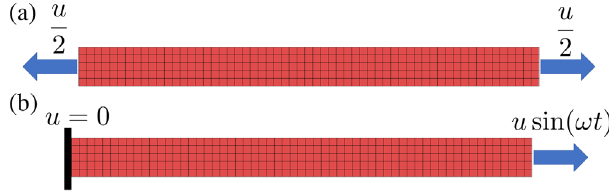
FIG. 14. A long bar with aspect ratio 59 = 5 is used to study the mechanical properties of the MSM. (a) Two equal and opposite displacements along the bar ’ s long axis are applied to the ends of the bar. This loading is used to find the relation of the Young ’ s modulus and Poisson ratio with the penalty volumetric pressure and to find the stress-strain relation of the MSM. In this loading case, no boundary condition is introduced, because at all times the bar is in force and moment equilibrium. (b) A periodic displacement is applied to one end of the bar while the other end is kept fixed. This loading is used to investigate the storage and loss modulus of the MSM.